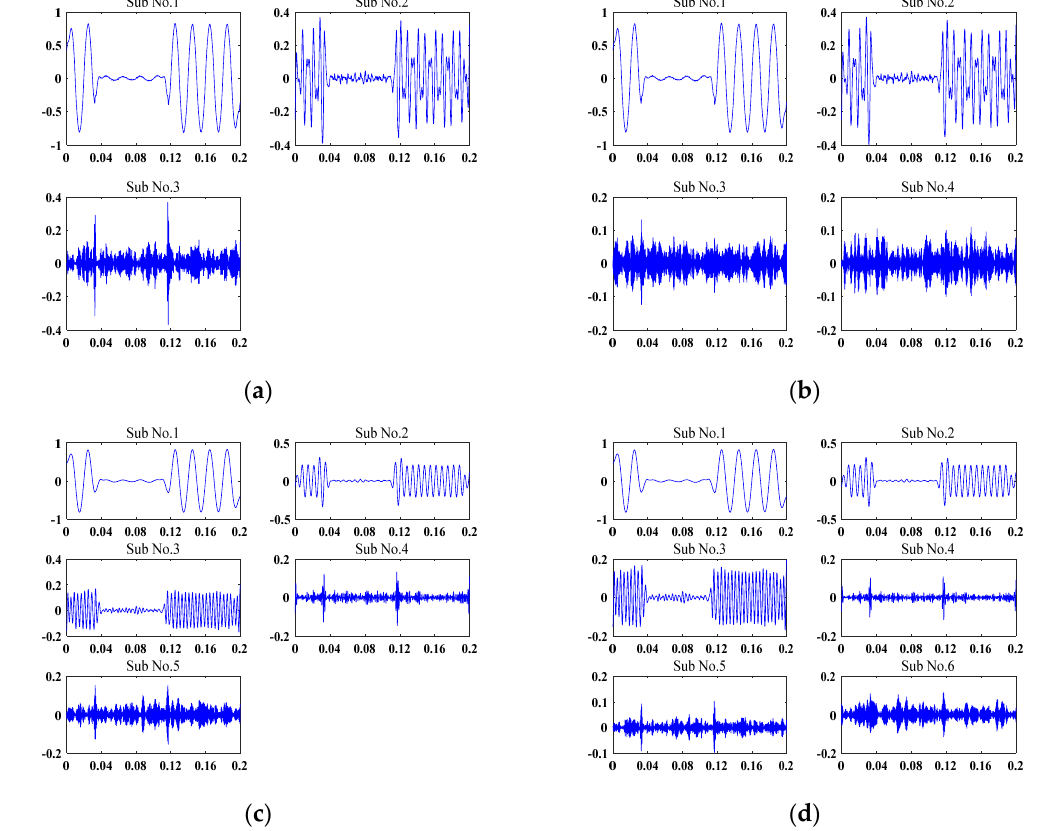
Figure 7. Power quality disturbances (PQD) signal decomposition results by variational mode decomposition (VMD). ( a ) When K = 3 by VMD; ( b ) when K = 4 by VMD; ( c ) when K = 5 by VMD; and, ( d ) when K = 6 by VMD.